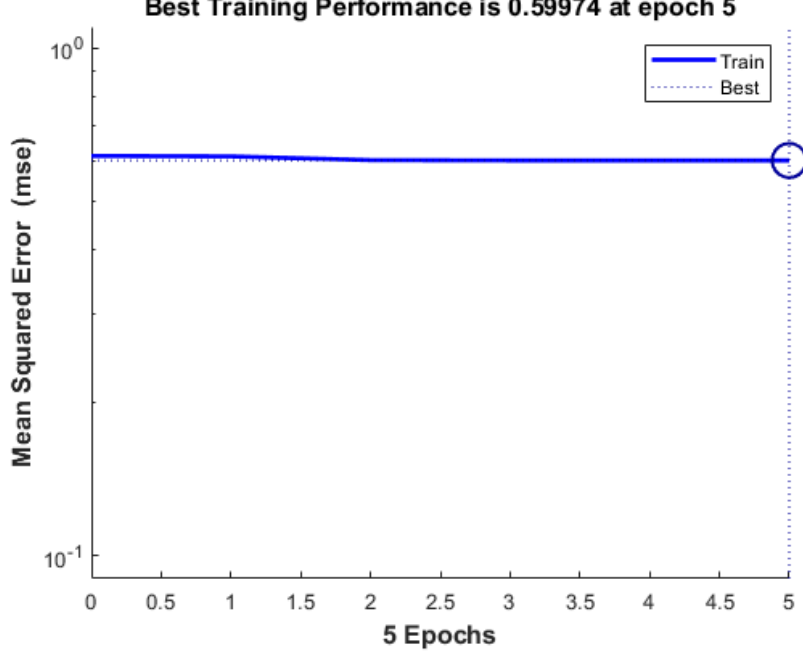
Figure 43. Neural network controller training state.